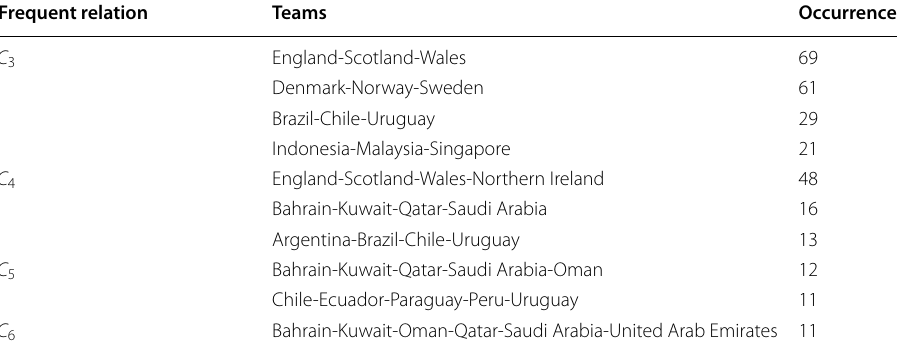
* C n stands for a relation involving n teams